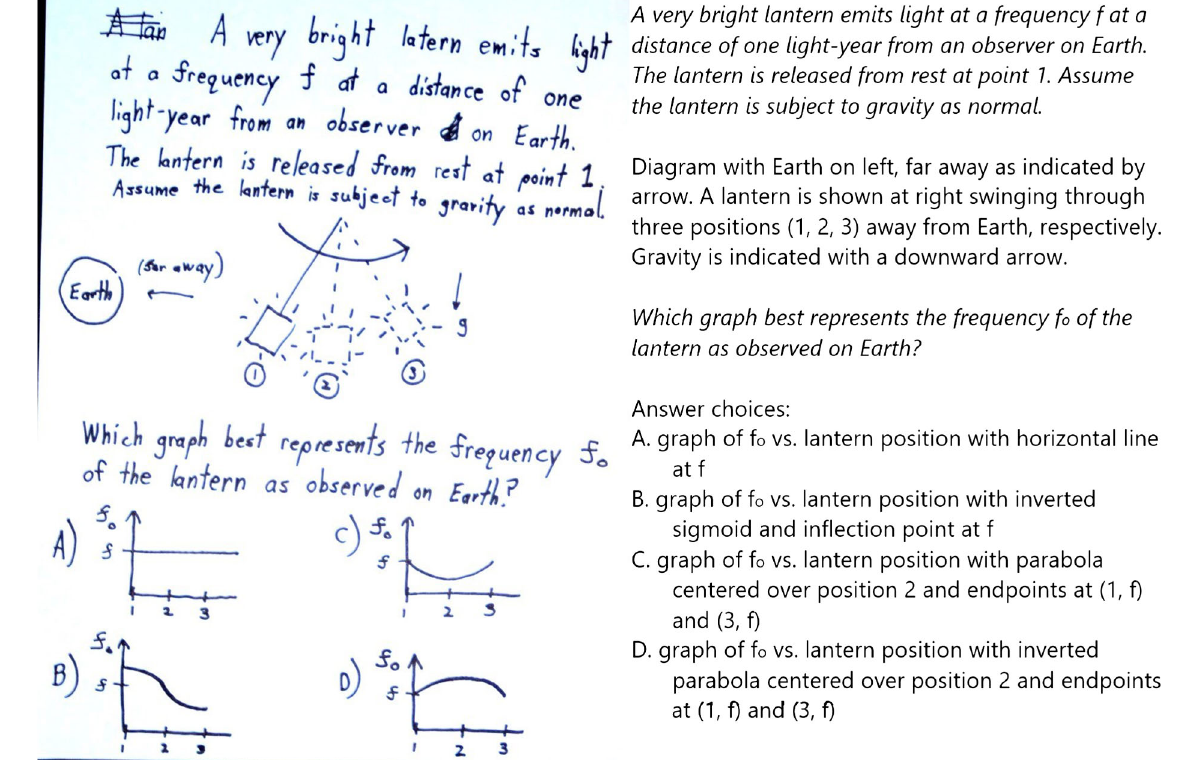
FIG. 3. Example B from the faculty-produced Think-Pair-Share questions. The original is reproduced on the left with a transcript on the right. Italicized portions indicate text of question